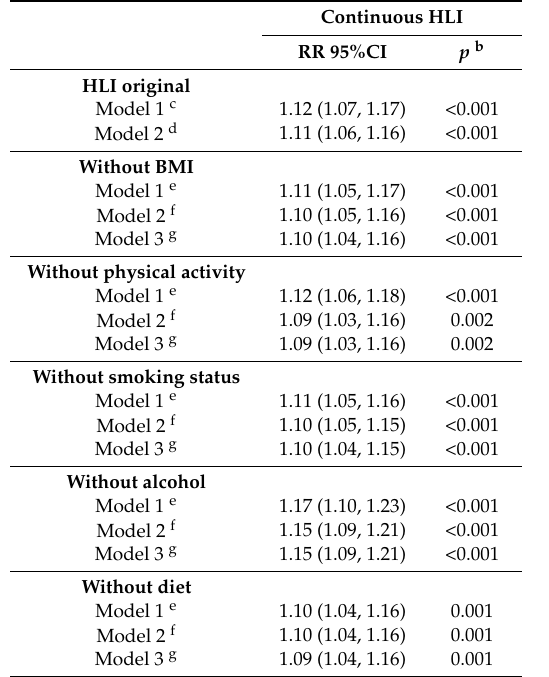
Table 2. Association between the original and modified versions of the continuous HLI and healthy aging ( N = 2203)